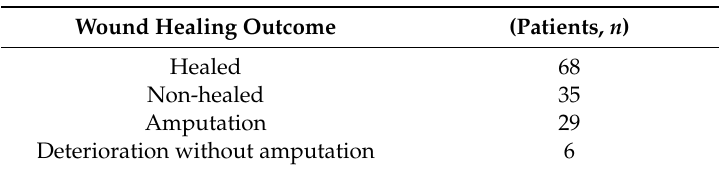
Table 2. Wound healing